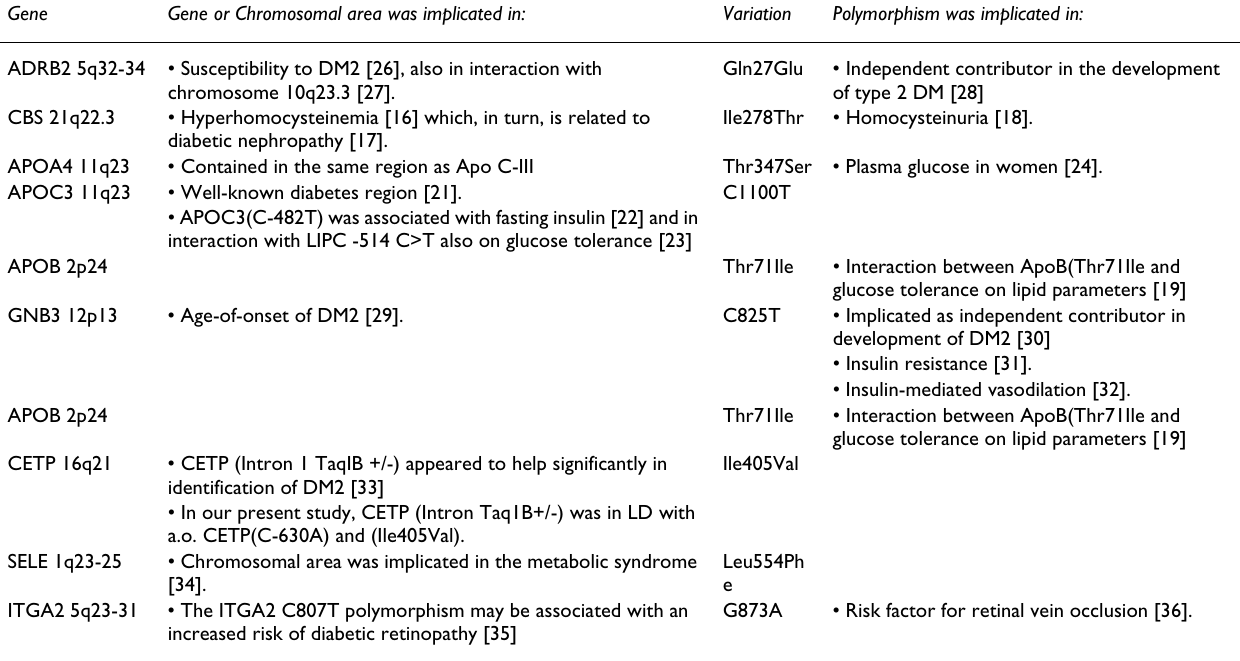
Table 8: Known effects of the genes and polymorphisms involved in susceptibility for T2DM only (with the false discovery rate of 0.125), with focus on parameters that are directly related to insulin resistance and T2DM. Gene Gene or Chromosomal area was implicated in: Variation Polymorphism was implicated in: